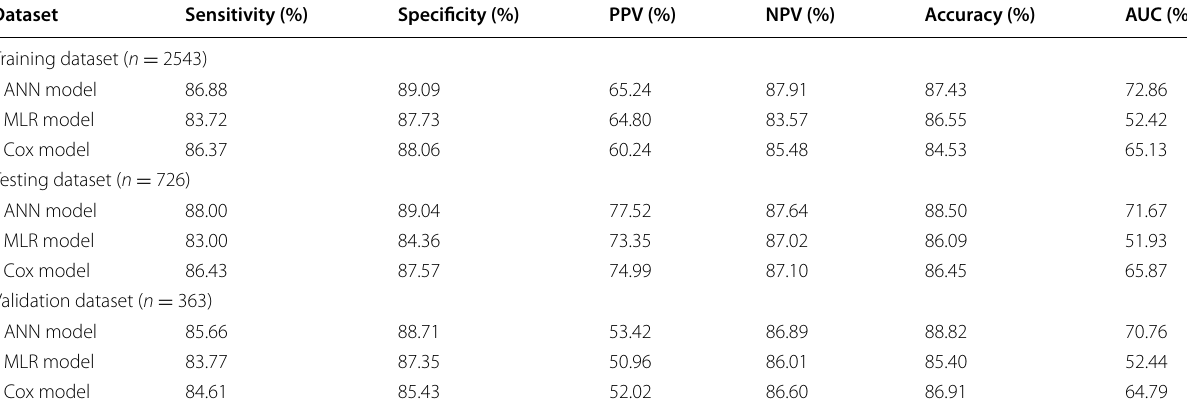
Table 3 Comparison of performance indices of the artificial neural network (ANN), MLR, and Cox regression models for predicting 5-year postoperative mortality of breast cancer patients